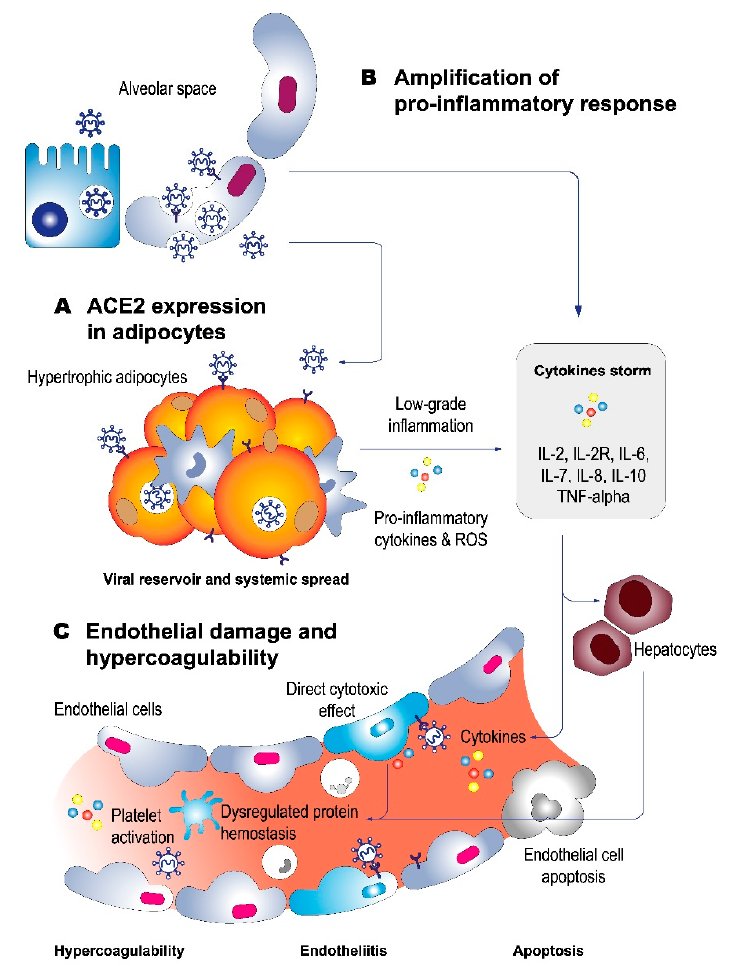
Figure 1. Pathophysiology of complications associated with obesity in COVID-19. Obesity is a recognized risk factor for complications in SARS-Cov-2 infection, which is associated with various mechanisms. SARS-CoV-2 enters the cell through the interaction of the S protein with the ACE2 receptor expressed in various cell types. Proposed mechanisms include: ( A ) ACE2 expression in adipose tissue, which contributes to increased susceptibility to infection and viral systemic spread; ( B ) chronic inflammation and amplification of the pro-inflammatory response, characterized by a deregulation of the immune response associated with progression to severe and critical conditions characterized by multiple organ failure mediated by apoptosis and alteration of lung function, triggering different respiratory complications; and ( C ) endothelial damage and hypercoagulability, a phenomenon mediated by the direct cytotoxic action of the virus on the endothelial cell that expresses ACE2, generating endothelial disease and apoptosis. On the other hand, significant changes have been described in the expression of procoagulant proteins and regulation of fibrinolysis, release of microparticles derived from platelets and platelet activation induced by the generation of reactive oxygen species (ROS), which generates a state of hypercoagulability, predisposing the patient to the development of